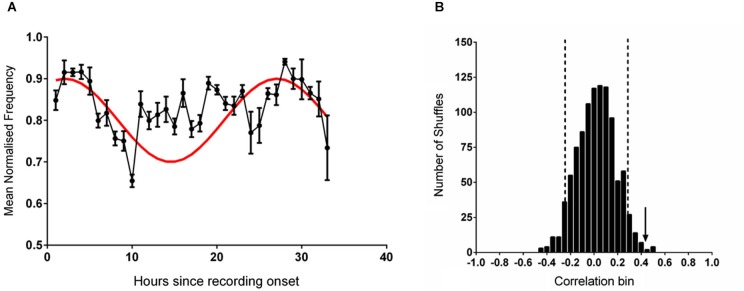
(A) The mean (±sem) normalized frequency of spontaneously generated hippocampal theta rhythm during each hour of recording (black line). The reference sine wave used for comparison is shown in red. (B) The frequency distribution produced by correlating 1000 shuffled versions of the data shown in (A) against the reference sine. The vertical dashed black lines demark two standard deviations from the mean of the distribution. The vertical black arrow indicates the magnitude of the correlation of the unshuffled data shown in (A) against the reference sine.